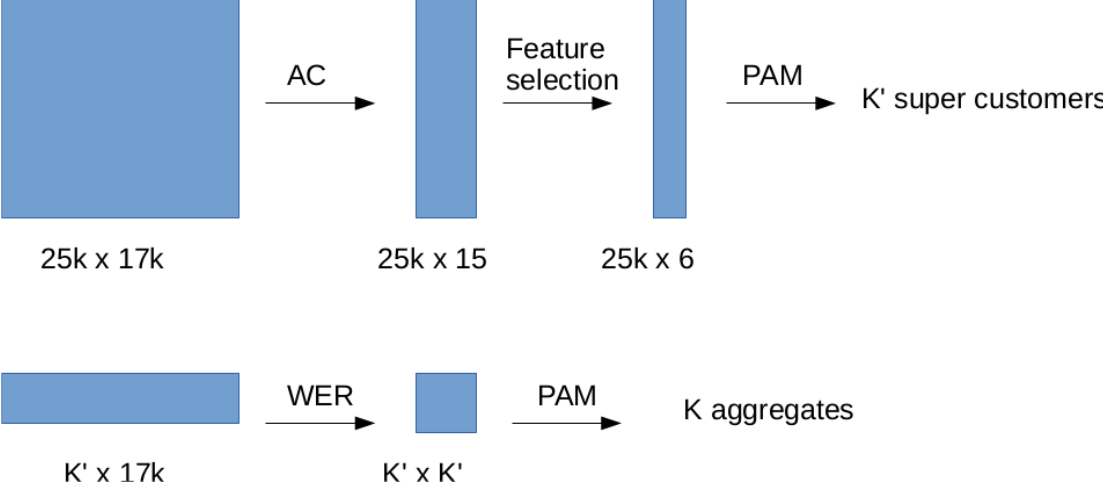
Figure 8. Two step